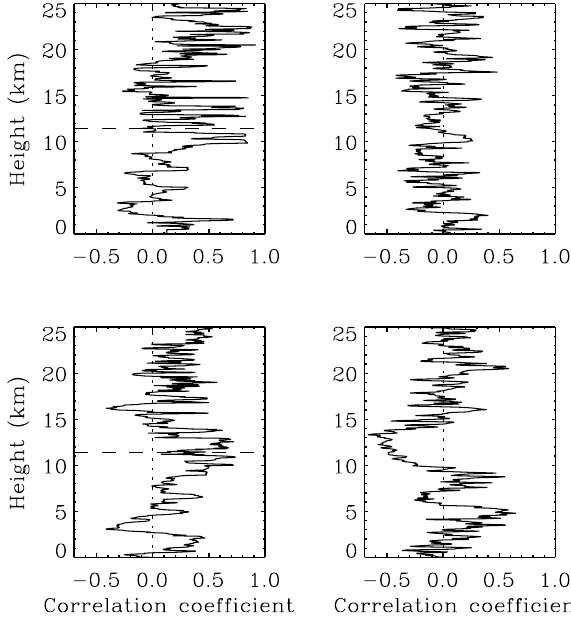
Fig. 10. Similar to Fig. 6, but for correlation coefficients in January 2007. The horzional dashed lines denote the maximum zonal wind